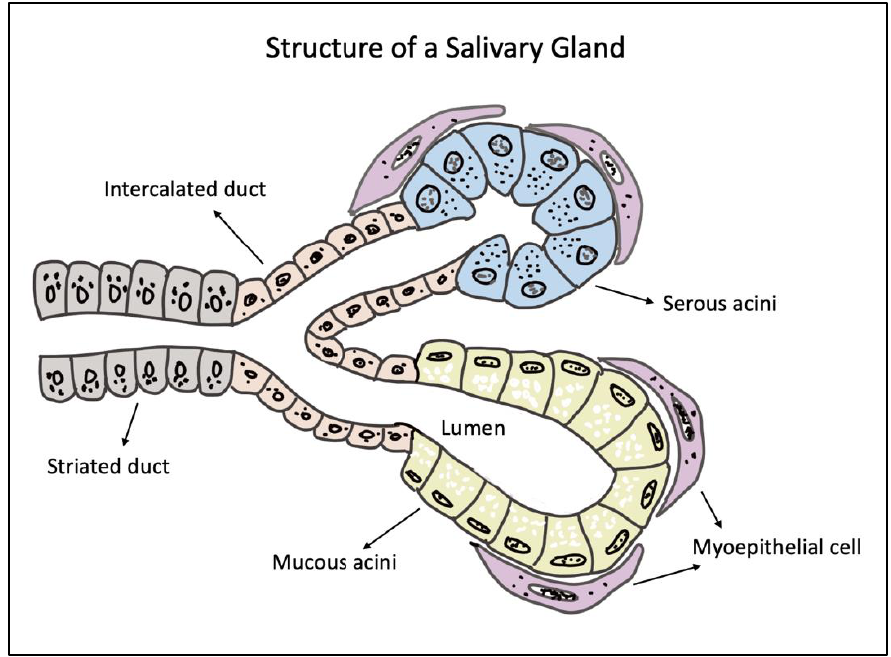
Figure 1. Schematic diagram of a salivary gland structure showing the secretory end pieces made of mucous and serous acini, supported by overlying myoepithelial cells. The secretory units extend to form the intercalated, striated, and excretory ducts through which saliva passes into the oral cav-